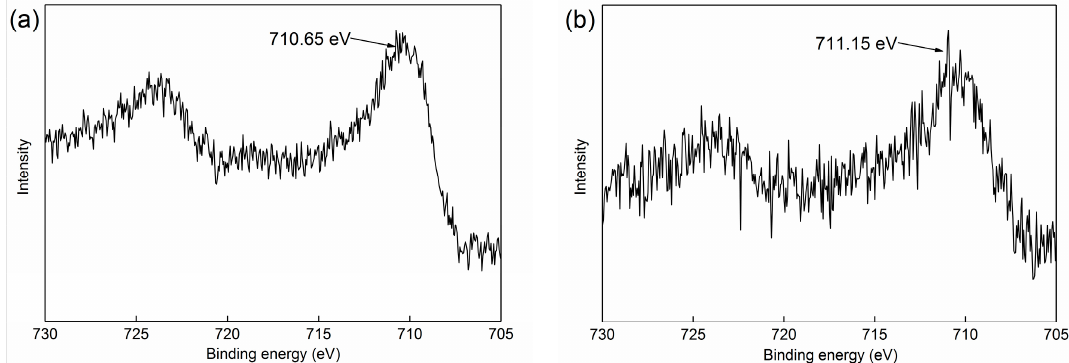
Figure 15. Fe 2p spectra of ( a ) celestite treated with ferric ions and ( b ) celestite treated with ferric ions and NaOL, (ferric ion: 5 × 10 -5 mol/dm 3 , NaOL: 5 × 10 − 5 mol/dm 3 ).